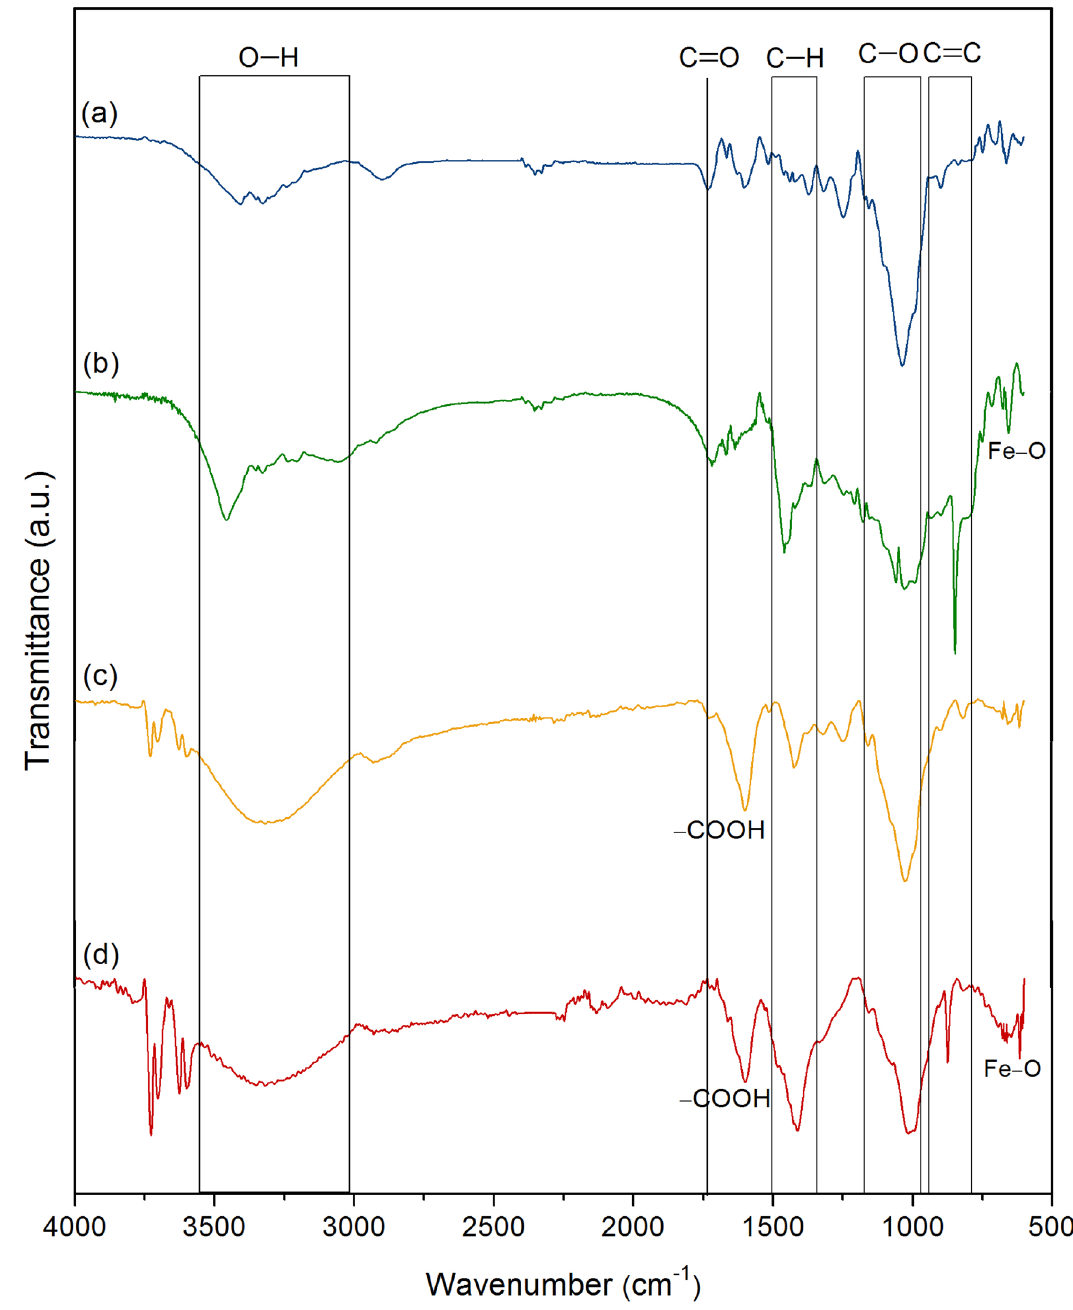
Figure 4. The chemical functional groups of ( a ) sugarcane bagasse powder (SB), ( b ) sugarcane bagasse powder doped iron(III) oxide-hydroxide (SBF), ( c ) sugarcane bagasse powder beads (SBB), and ( d ) sugarcane bagasse powder doped iron(III) oxide-hydroxide beads (SBFB) by FT-IR spectra